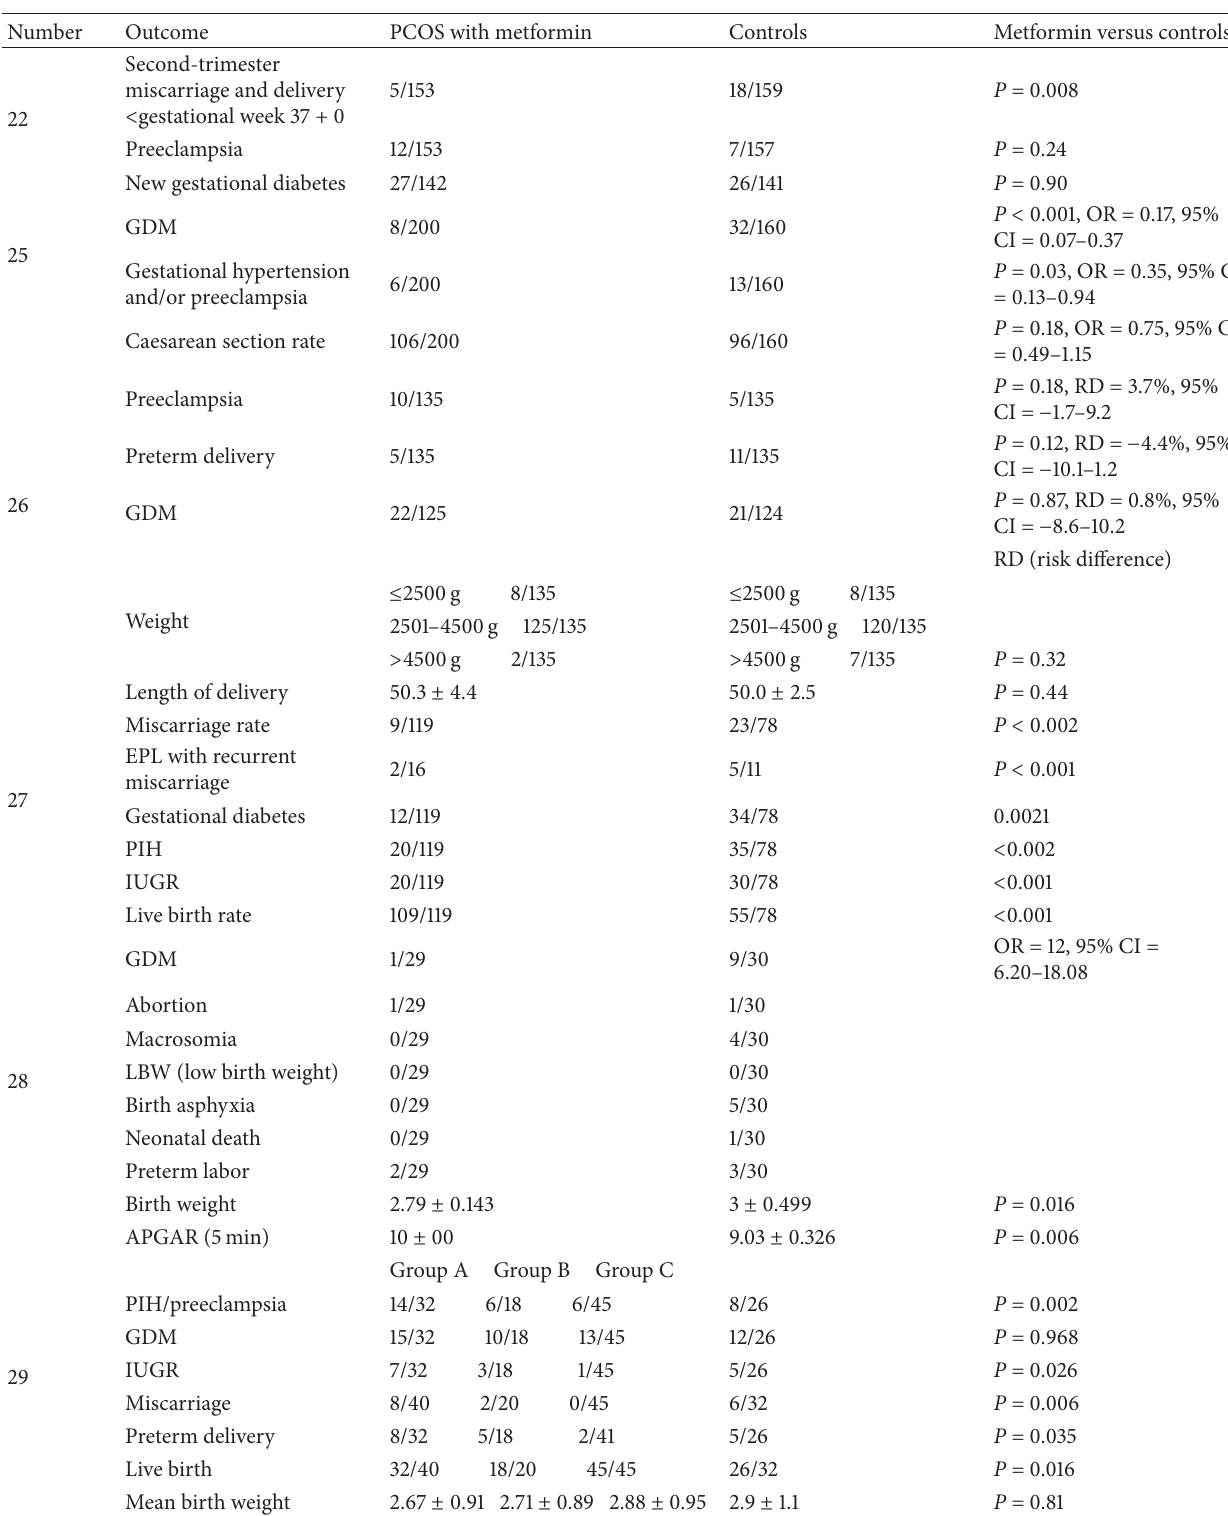
Table 4: Findings of the trials included in the